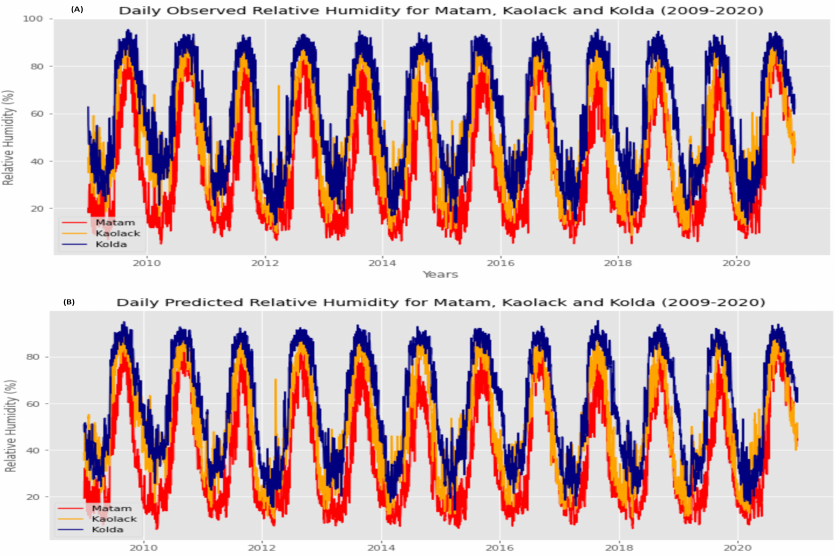
Figure 20. Observed and Forecasted Relative Humidity for Matam, Kaolack and Kolda (2009–2020).